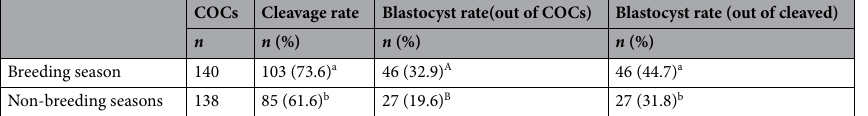
Table 1. Cleavage and blastocyst rates after in vitro fertilization of abattoir-derived buffalo oocytes in relation to season. a, b Values with different superscripts are significantly different; P < 0.05. A, B Values with different superscripts are significantly different; P <